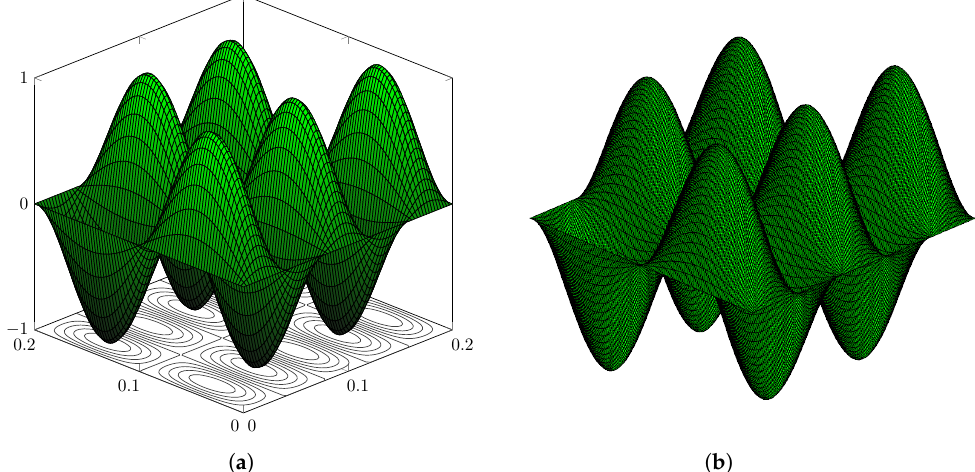
Figure 6. Simply supported LRMP in Figure 3, real part of Mode 144: ( a ) dynamic-stiffness approach and ( b ) finite-element method.